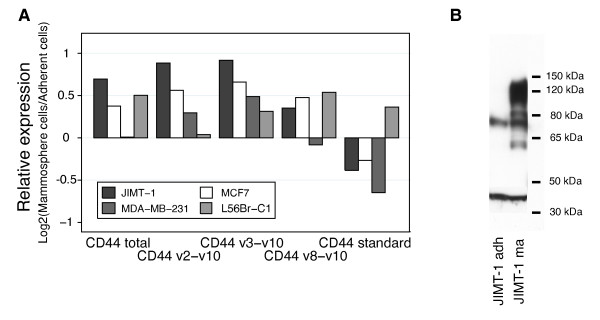
Mammosphere propagation of cell lines changed the mRNA and protein expression of CD44 isoforms. A. Breast cancer cell lines grown as monolayer cells or mammospheres were analyzed for mRNA expression of CD44 isoforms using q-RT-PCR. In general, the gene expression of the alternatively spliced variants CD44v2-v10, CD44v3-v10, CD44v8-v10 increased and the expression of CD44S decreased for cells cultured as mammospheres. B. Western blot analysis (CD44 antibody, clone 156-3C11) of the breast cancer cell line JIMT-1 confirmed changes in expression of CD44 variants for cells propagated as mammospheres.